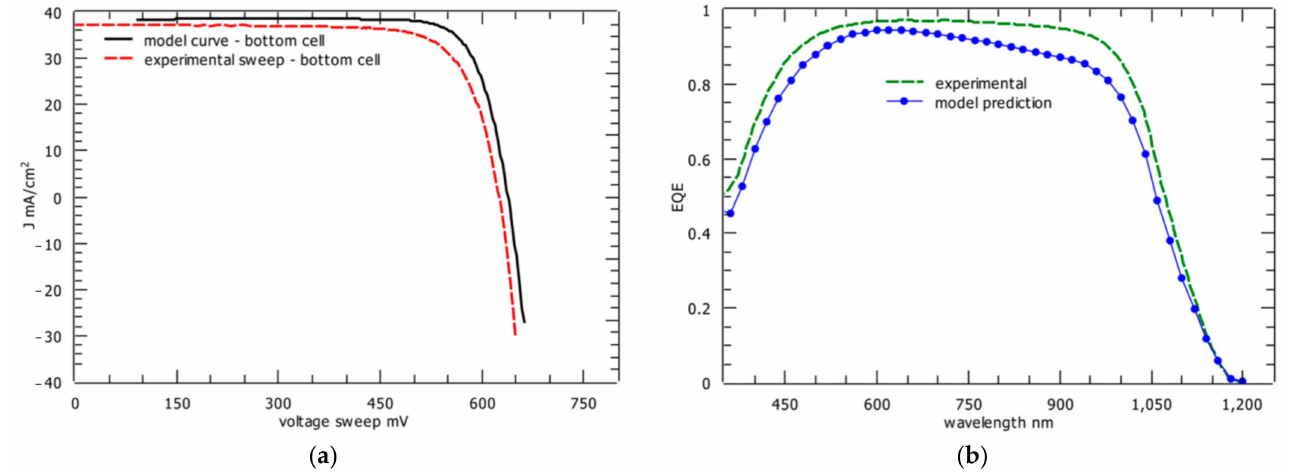
Figure 18. ( a ) Experimental vs. Quokka 2 simulated J-V curve; ( b ) experimental vs. Quokka 2 simulated EQE curve [28]. Table 7. Experimental electrical parameters for the bottom (c-Si) solar sub-cell [28].